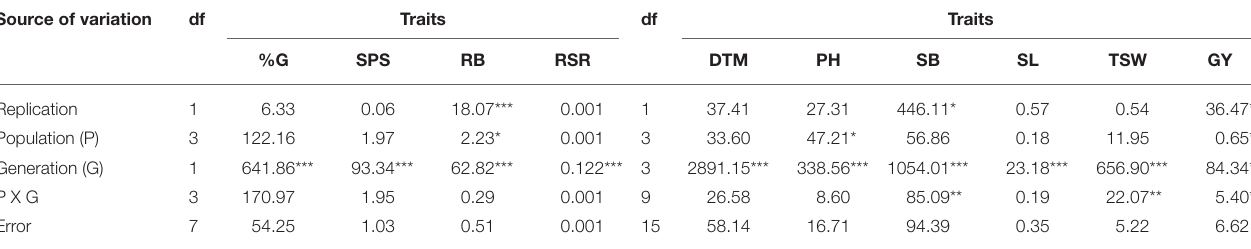
TABLE 3 | Mean squares and significant tests for traits measured in three EMS-treated and control populations of wheat planted across two and four generations. Source of variation df Traits df Traits